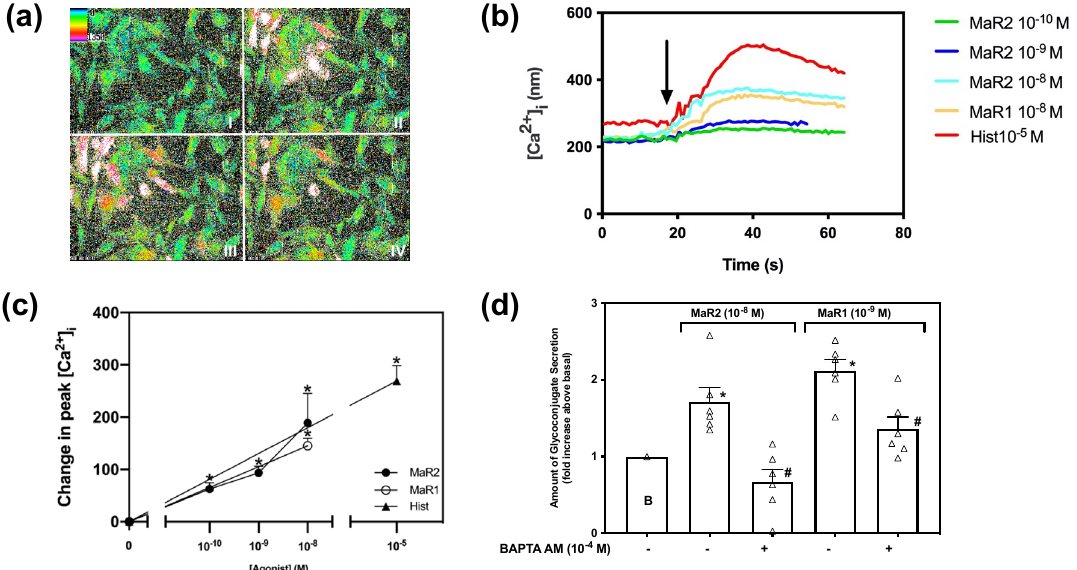
Figure 2. Maresin 2 increases [Ca 2+ ] i in rat conjunctival goblet cells. Pseudocolor images of rat conjunctival goblet cells stimulated with MaR2 (10 − 8 M) are shown in ( a ). MaR1 (10 − 8 M) is shown at four different times of stimulation. Panel I shows rat conjunctival goblet cell baseline [Ca 2+ ] i level before stimulation (AI), panel II 30 s after stimulation with MaR2 (10 − 8 M) (AII); panel III 50 s after stimulation (AIII); and panel IV 80 s after stimulation (AIV). Changes in [Ca 2+ ] i over time at different concentrations of MaR2 (10 − 8 M) are shown in ( b ). Changes in peak [Ca 2+ ] i after stimulation with MaR2 (10 − 8 M) are shown in ( c ) Goblet cells were preincubated with BAPTA/AM (10 − 4 M) and stimulated with MaR2 (10 − 8 M) or MaR1 (10 − 9 M) for glycoconjugate secretion ( d ). Data are mean ± SEM from three ( b , c ) and six ( d ) experiments). White triangles indicate individual data points. * shows significance above zero (basal). # shows significant difference between agonist and agonist +